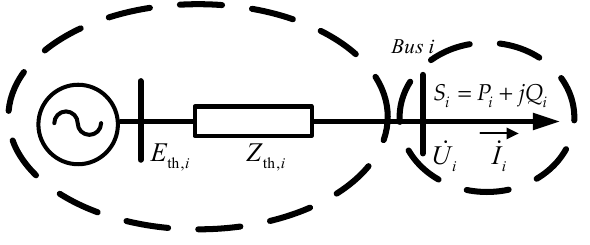
Figure 1. The Thevenin equivalent model.